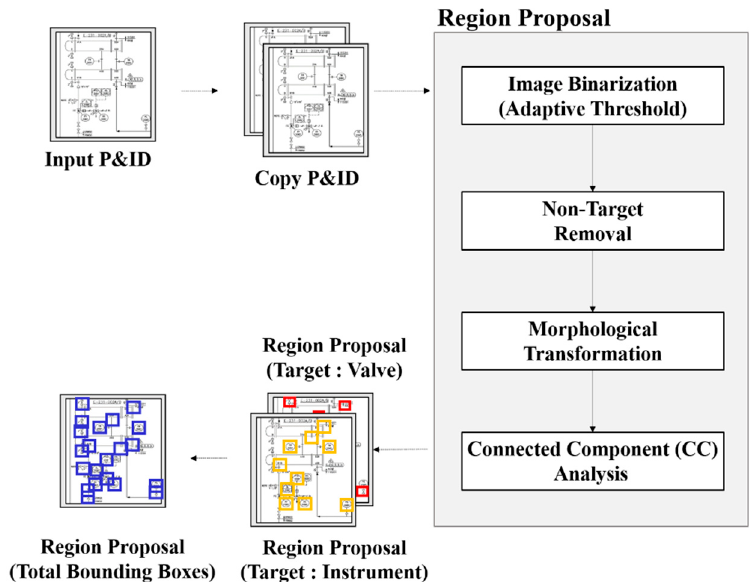
Figure 3. Procedure followed by the proposed region proposal network (RPN).